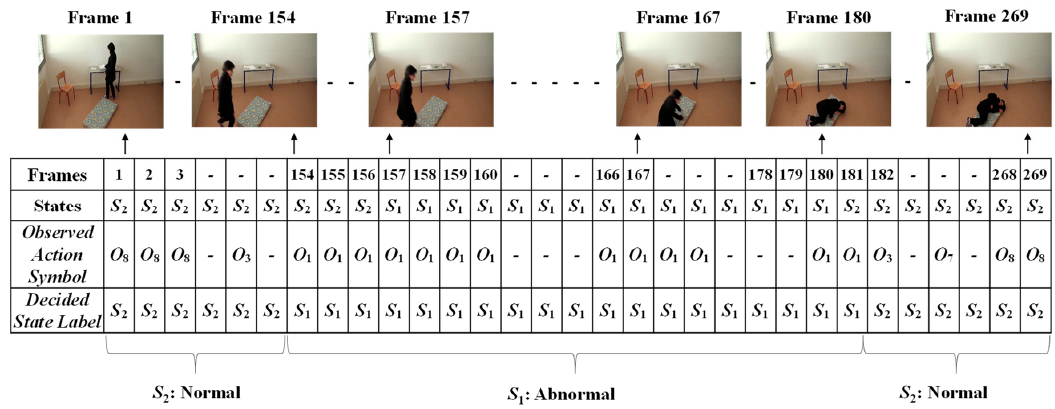
Figure 15. Results for deciding on the sequential abnormal and normal states for Mr. ONE (Video 1).